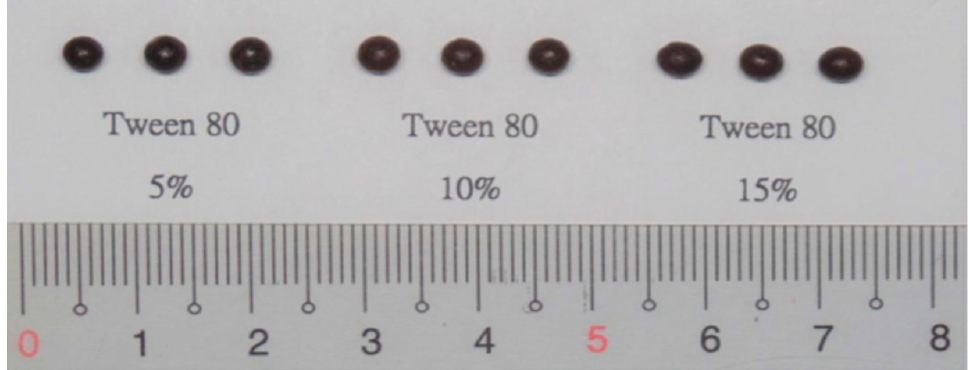
Figure 5. Dropping pills prepared by adding different concentrations of Tween 80 .